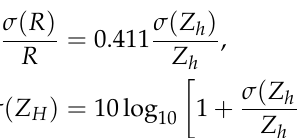
Figure 1. Comparison between hourly rain amounts of RG and MZZU radar: ( a ) R = 0.238 Z 0.411 ( b ) R = 0.0833 Z 0.602 collected between 6 April 2016 and 2 June